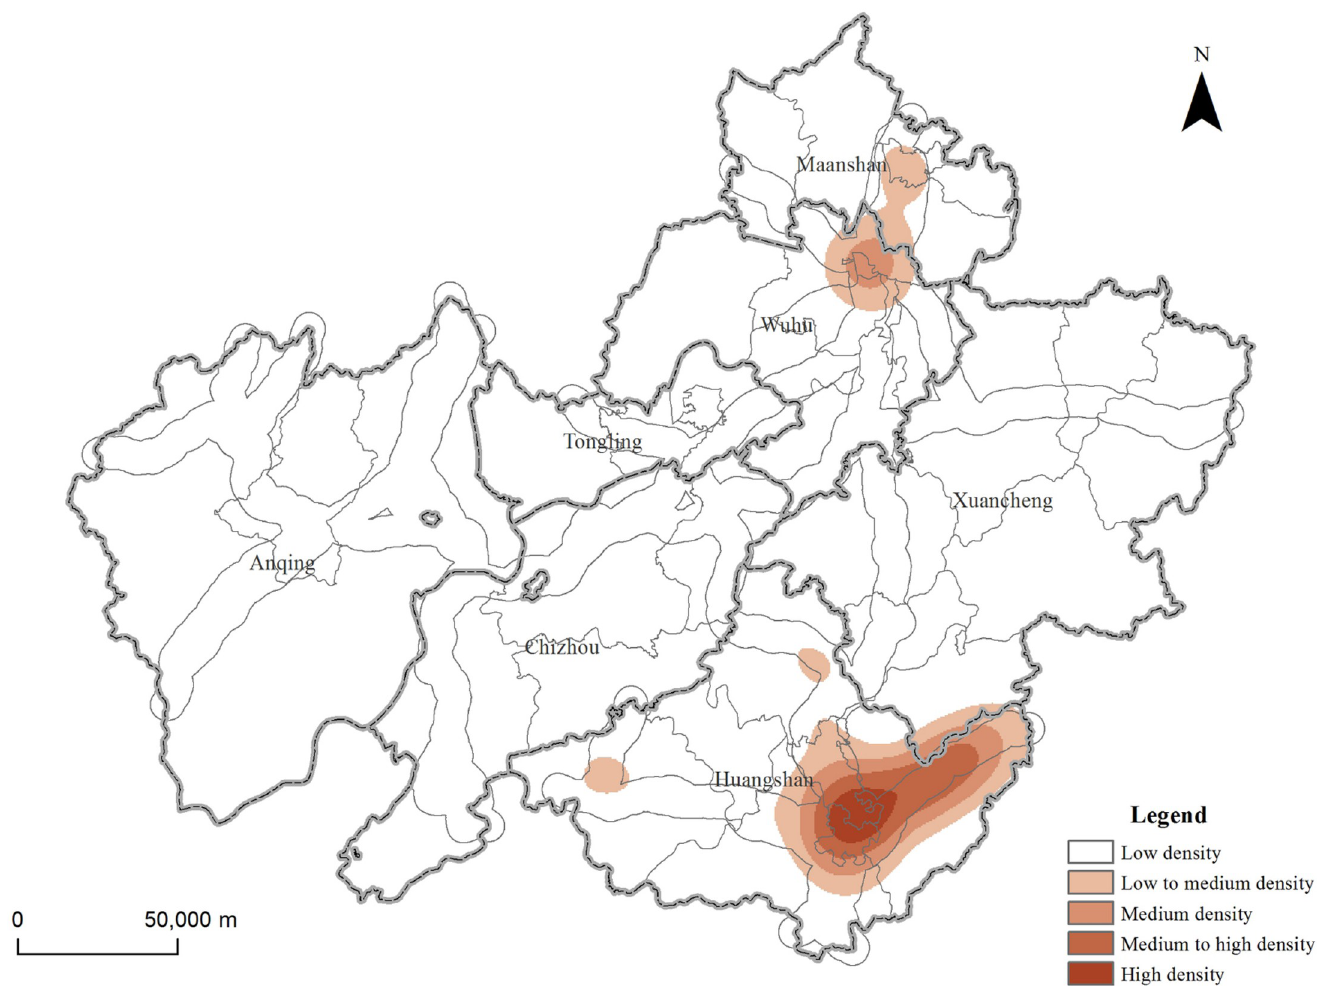
Fig 6. Analysis of tourist attractions and traffic factors in the demonstration region. Contains information from OpenStreetMap and OpenStreetMap Foundation, which is made available under the Open Database